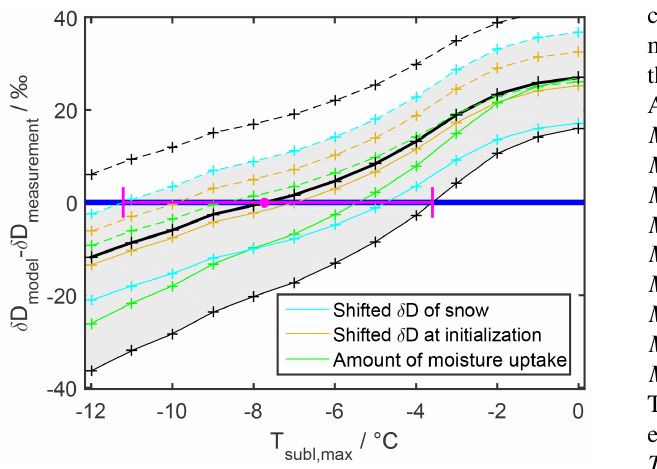
Figure 10. Mean difference between modeled and observed δ D of water vapor at Karlsruhe for selected cold snap events ( (cid:49)δ D). Each cross represents the (cid:49)δ D obtained from one model configuration with specific model assumptions regarding the T subl,max , the δ D of snow, the δ D at the model initialization, and the amount of mois- ture uptake. The thick black line connects the (cid:49)δ D from 16 model configurations with T subl,max between − 15 and 0 ◦ C and the model assumptions of M S_MW ,T and illustrates the increase of the subl,max modeled δ D values with increasing maximum skin temperature al- lowing non-fractionating sublimation. The gray shaded area depicts possible systematic changes of the (cid:49)δ D in the case of a systematic deviation of the δ D of snow from the RCWIP climatology (light blue), a systematically changed δ D at the model initialization (yel- low), a systematically changed amount of moisture uptake (green), and superposition of the different assumptions (thin black lines). The thin dashed black line corresponds to the model configuration M S_MW,+++ ,T , which does not allow reproducing the obser- subl,max vations in group “warm” and is therefore not considered in the gray shaded area of uncertainty. In magenta, optimal T subl,max for best agreement of model and observation (dot) and uncertainty of the optimal T subl,max (error bar) due to uncertainty of model assump- tions are